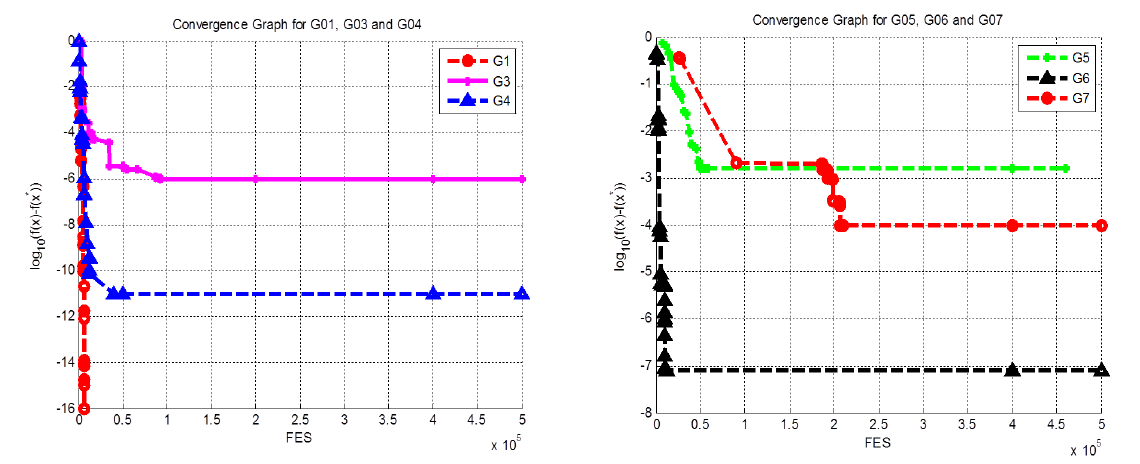
Figure 2. Convergence graph for G01 to